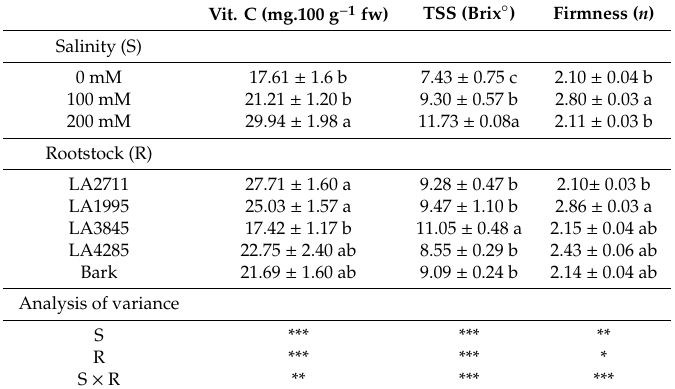
Table 8. E ff ect of salinity treatments, rootstocks and their interactions on fruits quality.